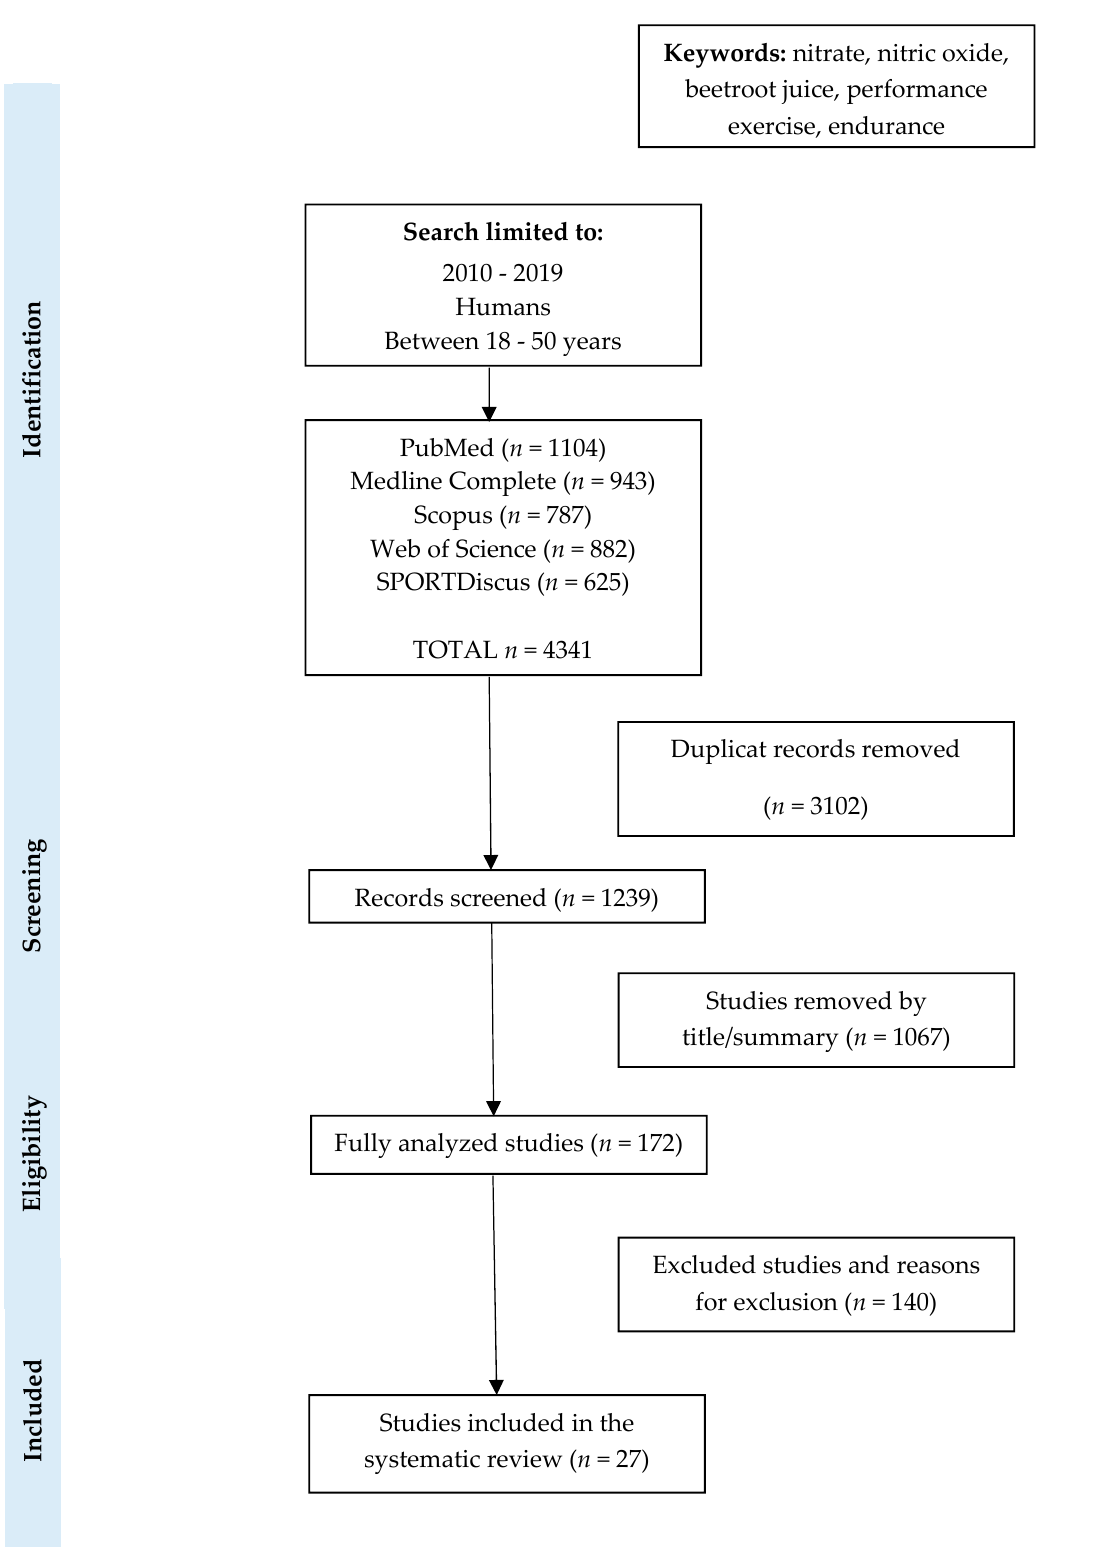
Figure 2. Preferred Reporting Items for Systematic Review and Meta-Analyses (PRISMA) flow. Summary of the systematic search and the study selection